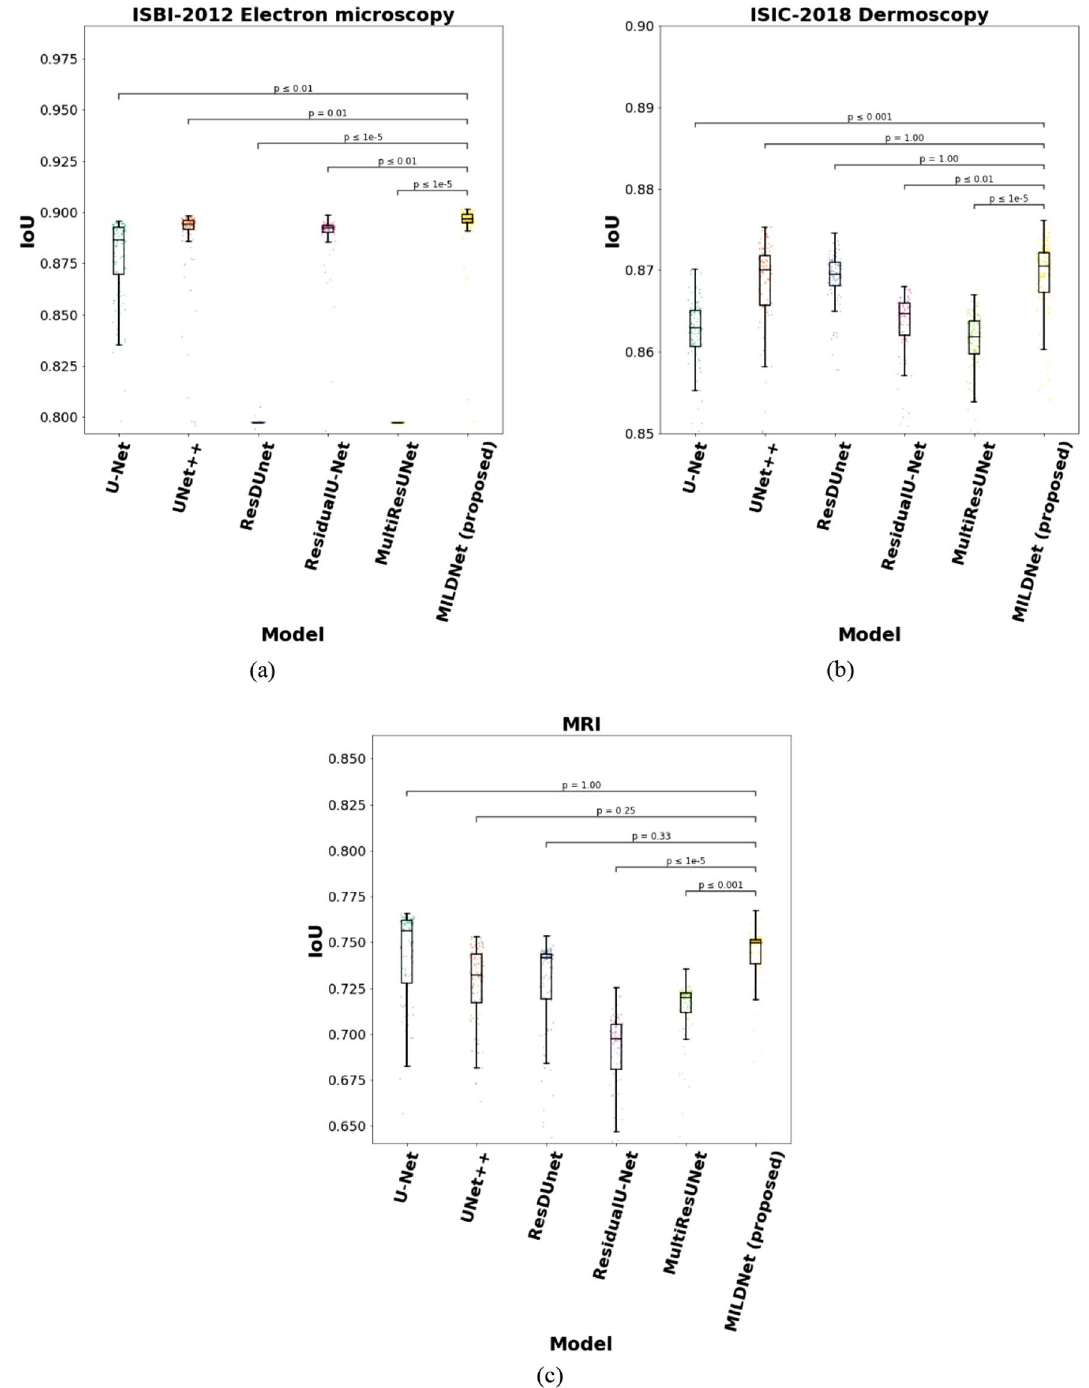
Figure 8. Statistical significance for the differences in segmentation performances of the MILDNet and the baseline approaches using t -test. The differences between the IoU values of the MILDNet and the baselines are statistically significant when p -value ≤ 0.05. Y-axis represents the overall IoU value of each model using a 5-fold CV on the entire dataset by merging the training, validation, and test sets of each biomedical dataset. The sub- figures (a–e) represents the box plot with the baseline approaches U-Net, UNet + + , ResDUnet, MultiResUNet and MILDNet (proposed) on the x-axis and the IoU values on the y-axis for all the five biomedical datasets used in this